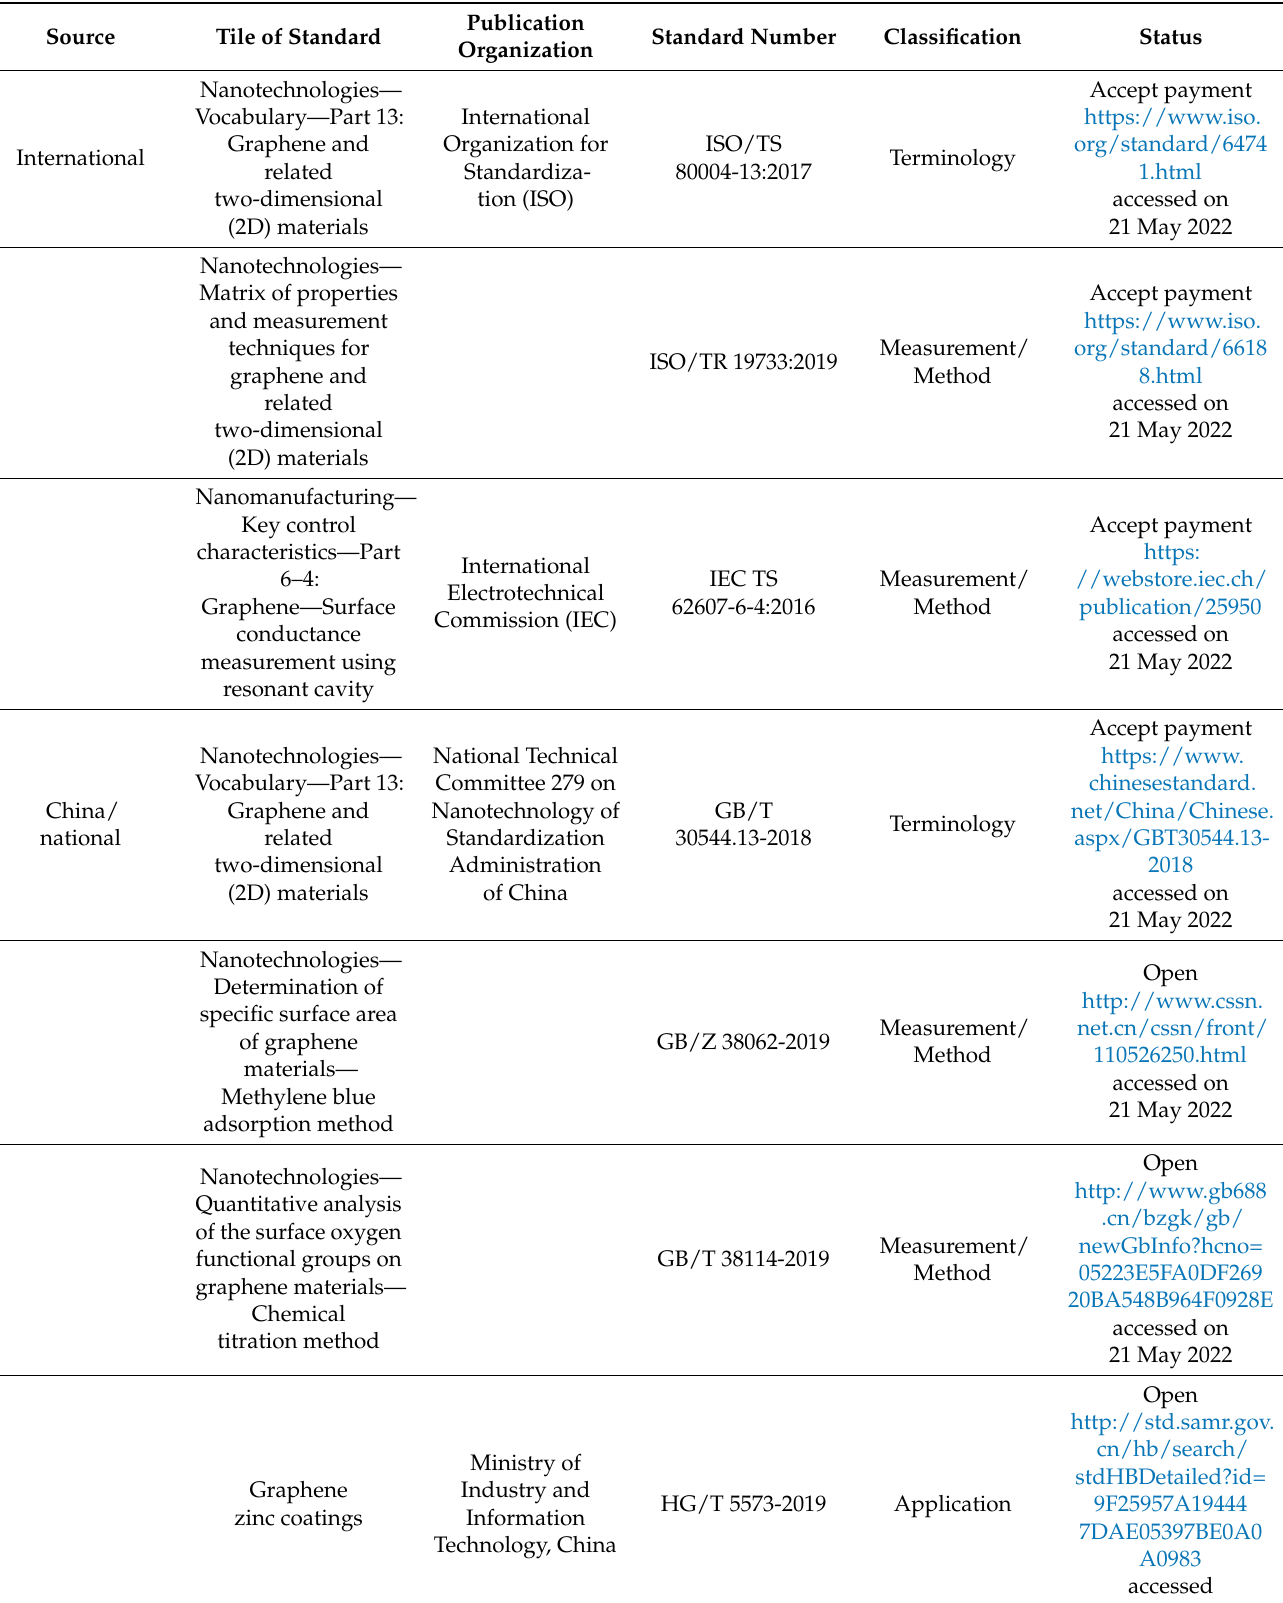
Table 1. Graphene-related standards that are publicly available. Reproduced from [56]; copyright © 2022, with permission from Elsevier. Data updated to February